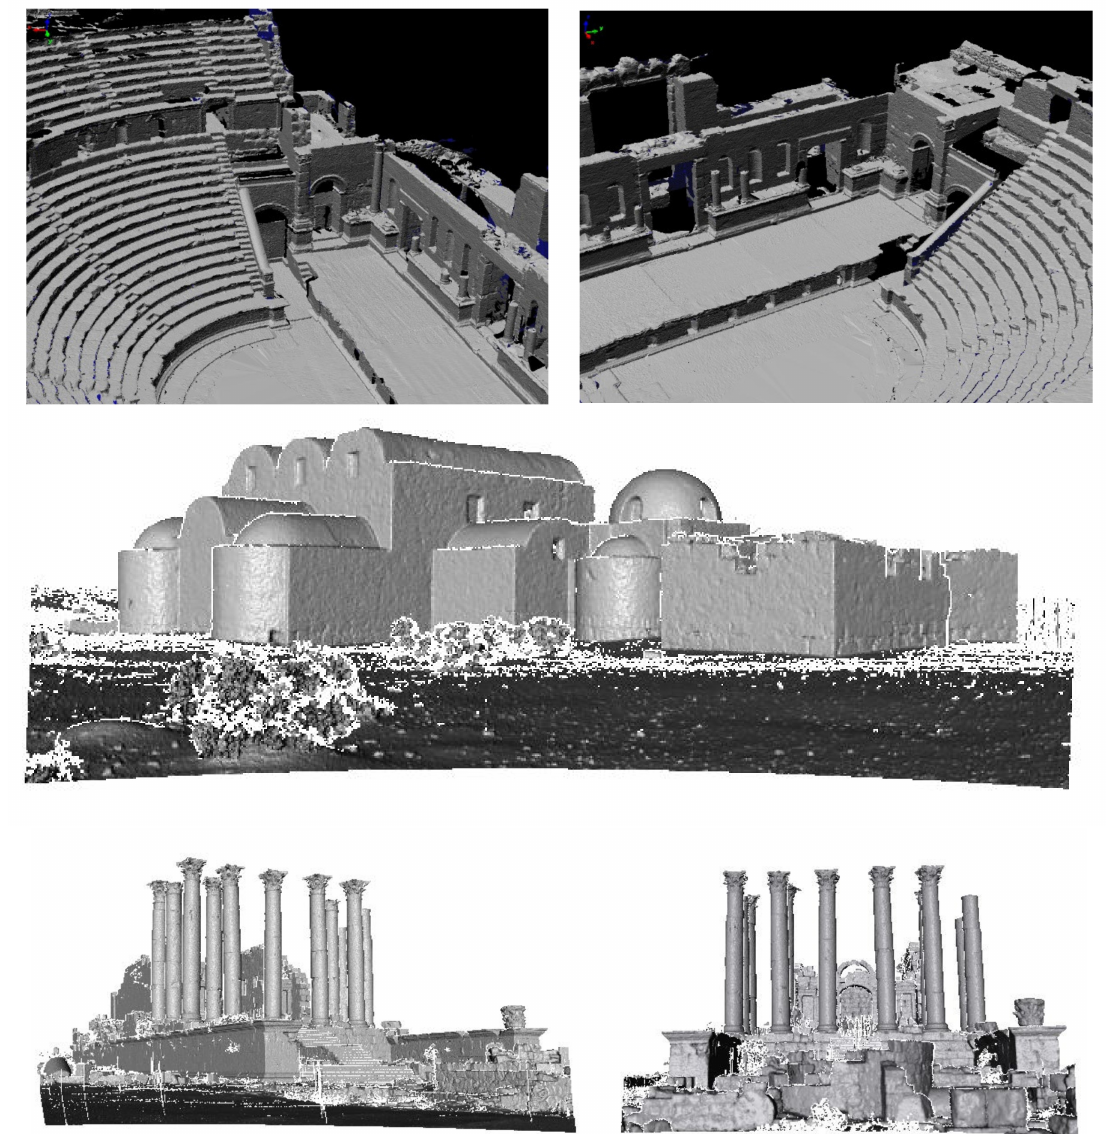
Figure 4. Three-dimensional meshed models of the experimental